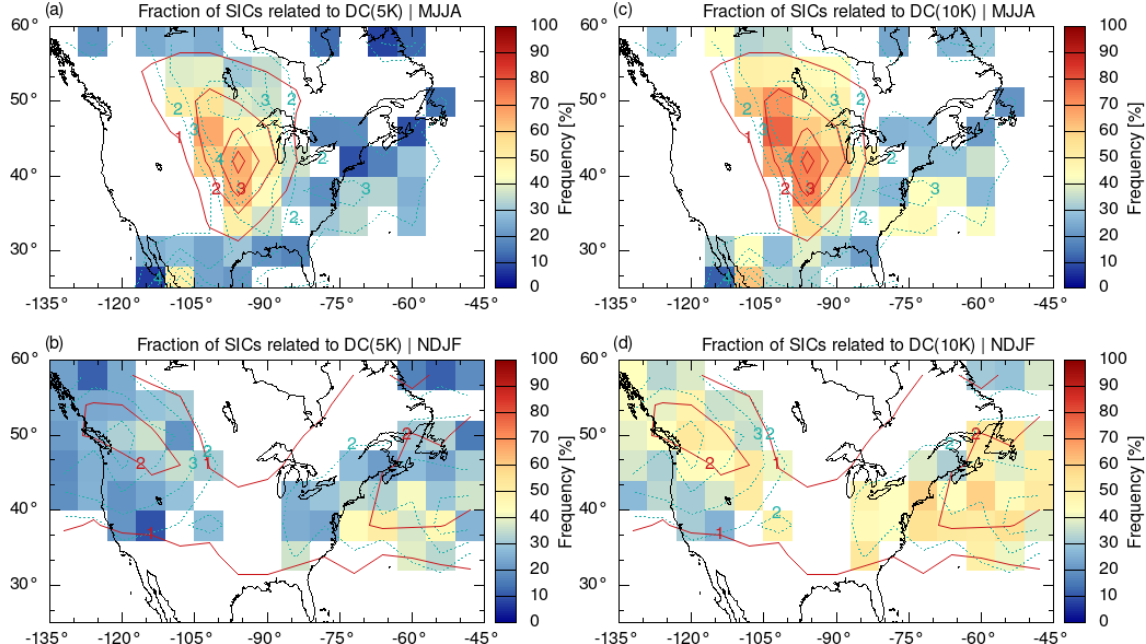
Figure A1. Fraction of SICs related to deep convection with temperature thresholds of 5K (a, b) and 10K (c, d) ; red contour lines are the occurrence frequency of deep convection, and blue dotted contour lines are the occurrence frequency of